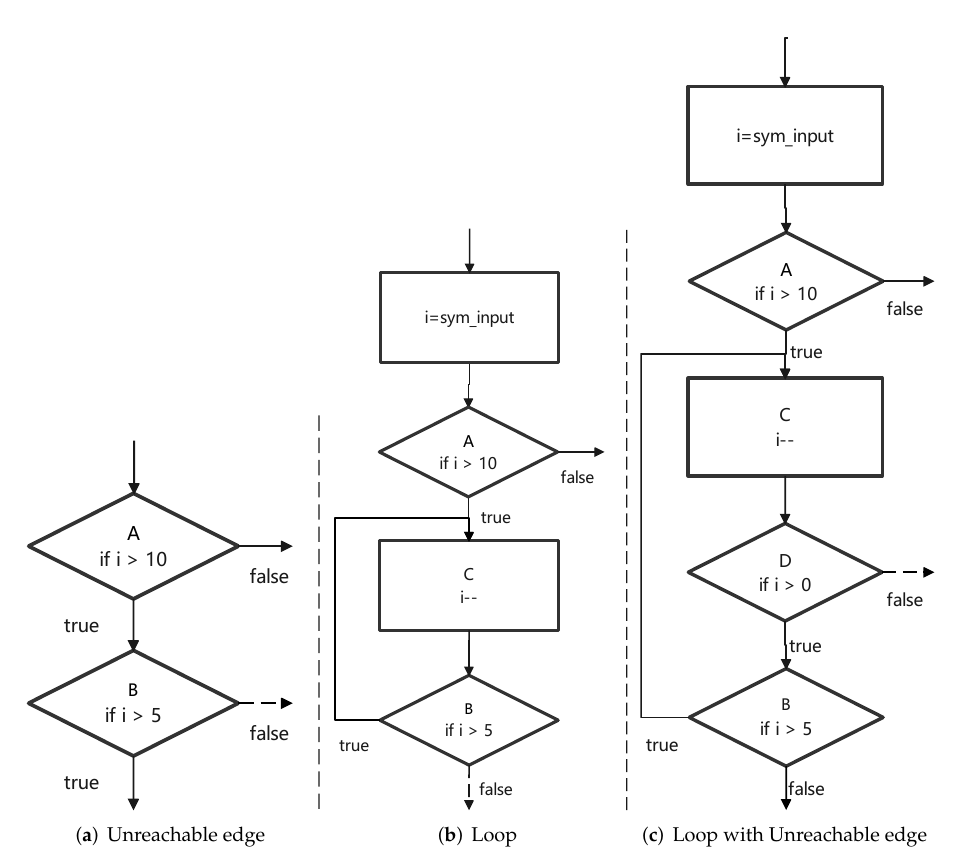
Figure 6. Accessibility of